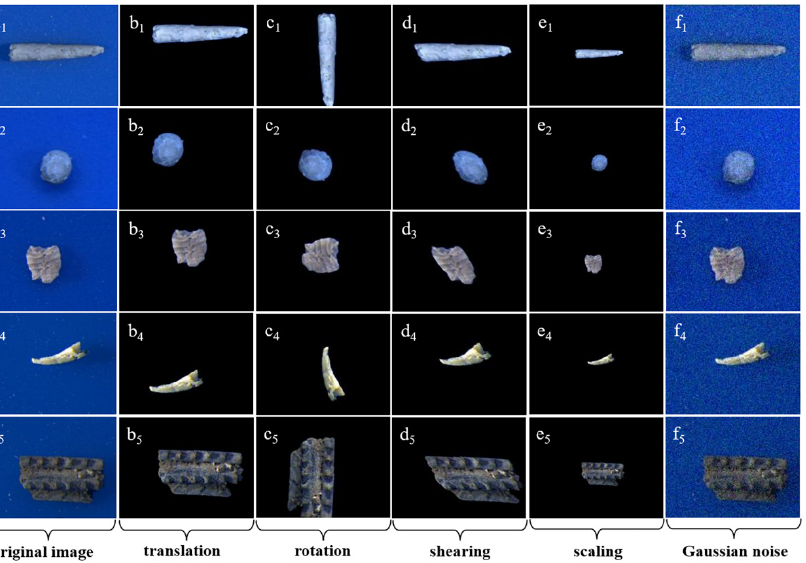
Figure 2. Images generated by data augmentation of some microfossils. ( a1 – a5 ) original images; ( b – e ) images after affine transformation ( b1 – b5 : translation, c1 – c5 : rotation, d1 – d5 : shearing, e1 – e5 : scaling) based on removing background; ( f1 – f5 ) images after adding Gaussian noise.